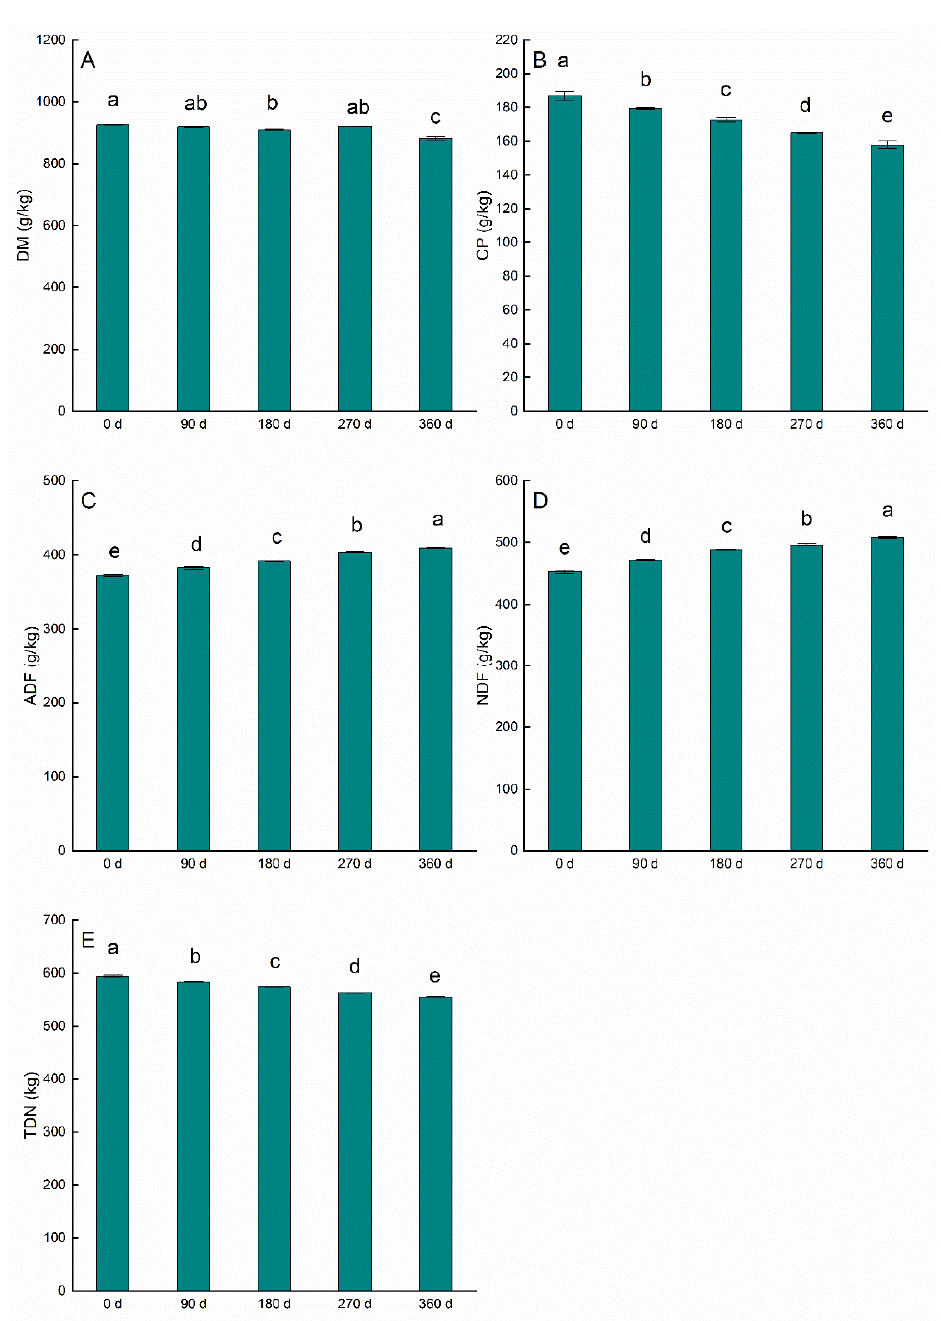
Figure 8. The effects of storage durations on nutritional quality of alfalfa ( A – E ). ( A ) dry matter (DM), ( B ) crude protein (CP), ( C ) acid detergent fiber (ADF), ( D ) neutral detergent fiber (NDF), ( E ) total digestible nutrients (TDN). Bars indicate standard error of the means. Different lowercase letters indicate significant difference at p < 0.05.